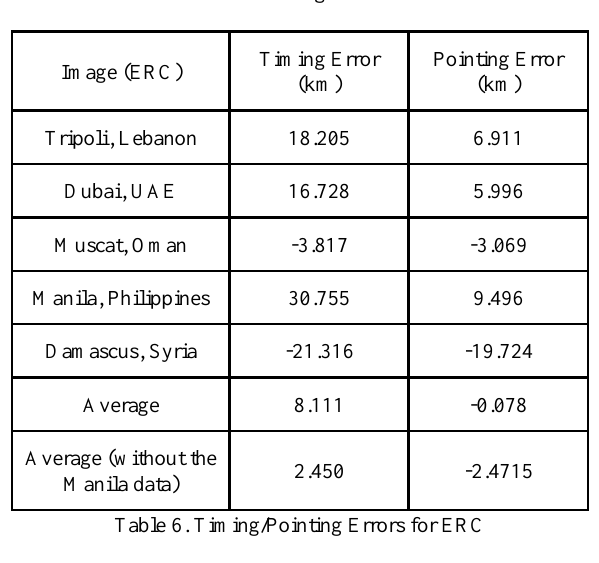
Figure 10. Damascus, Syria. Distance from programmed target to actual image center.